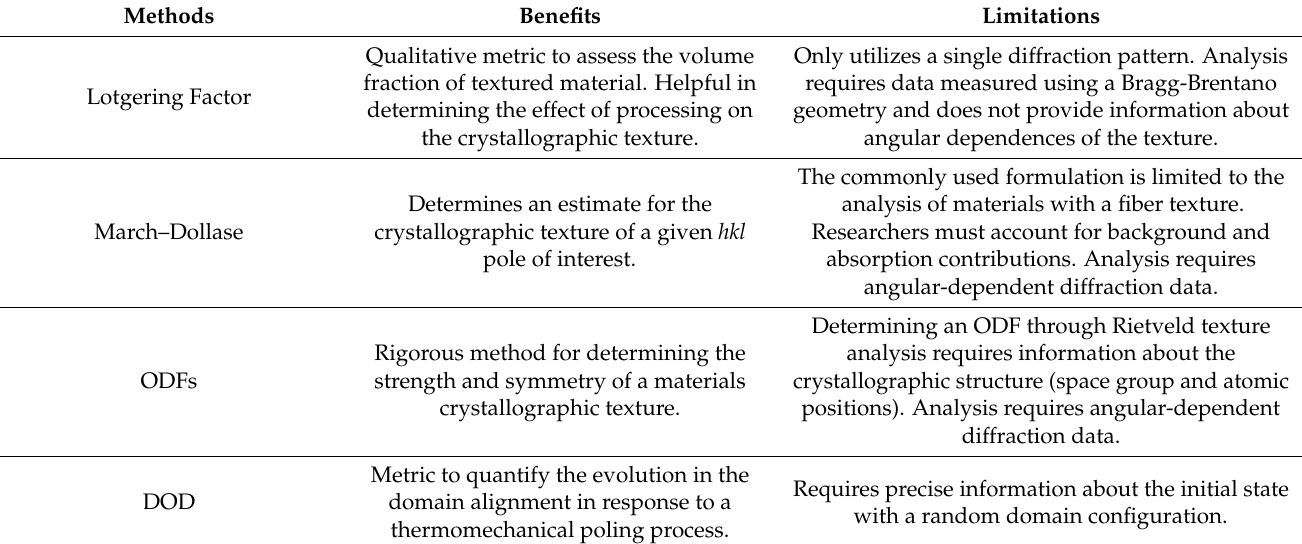
Table 2. Summary of the benefits and limitations of the qualitative and quantitative methods for assessing crystallographic textures in ferroelectric